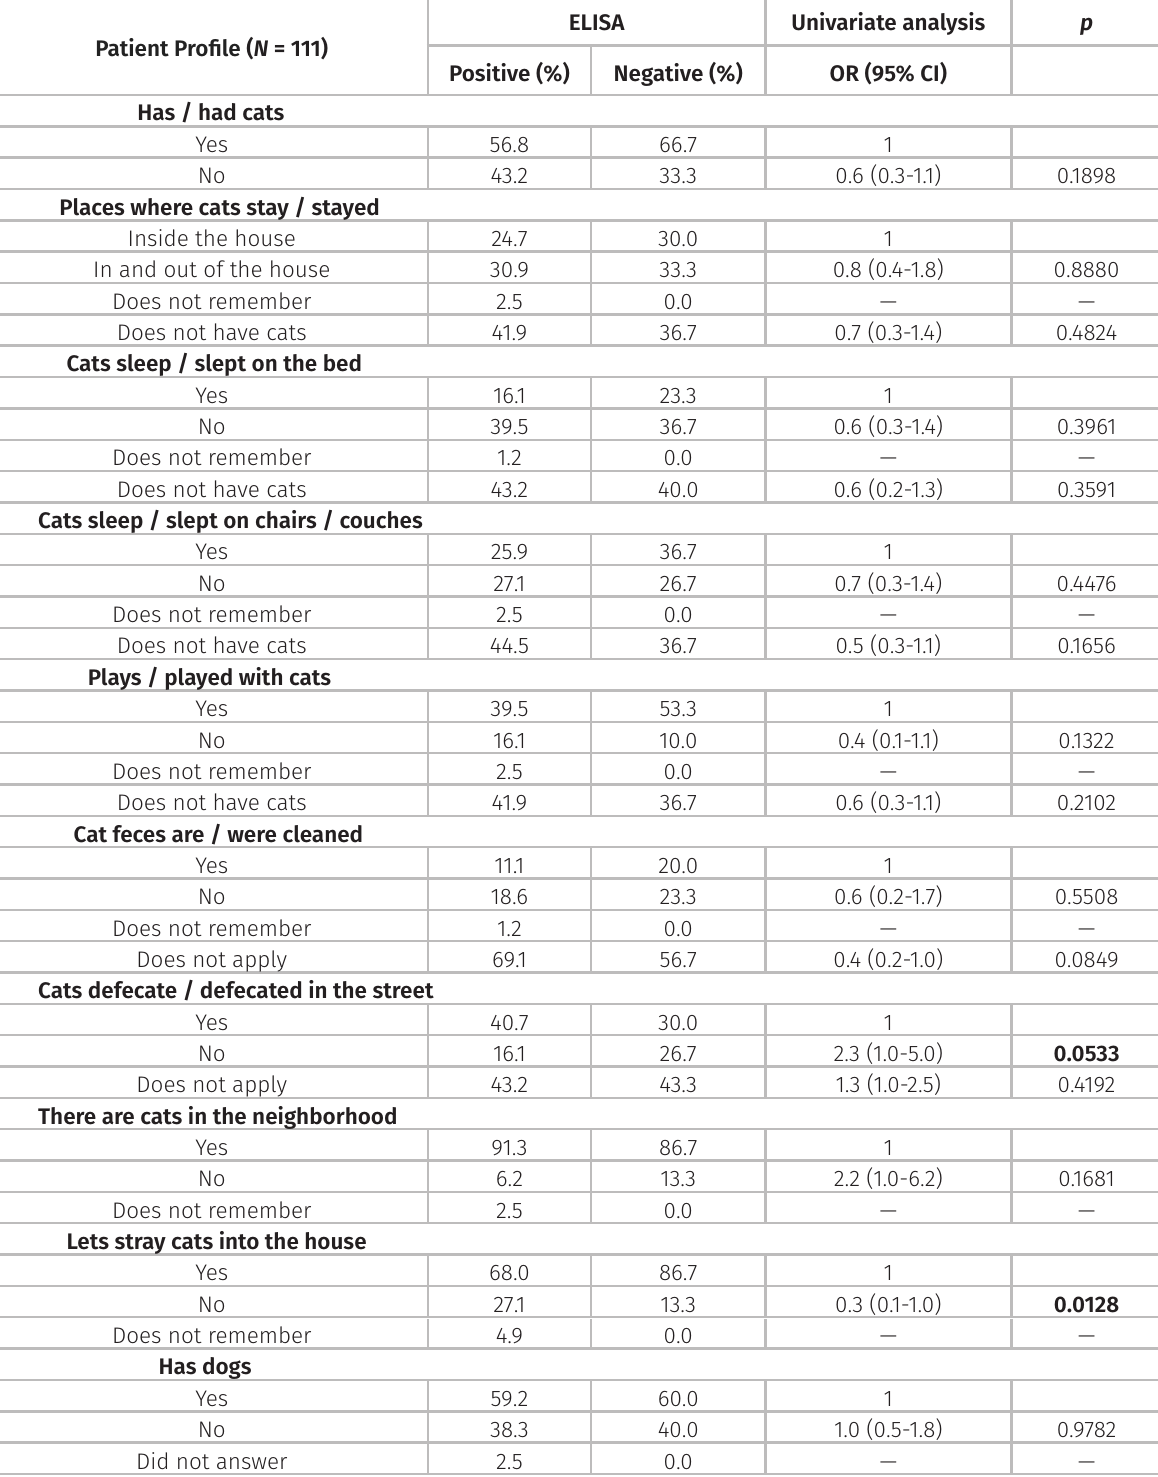
Table III. Univariate analysis of behaviors of patients who were attended by the Expert Assistance Service of Foz do Iguaçu city, Paraná state, Brazil, in